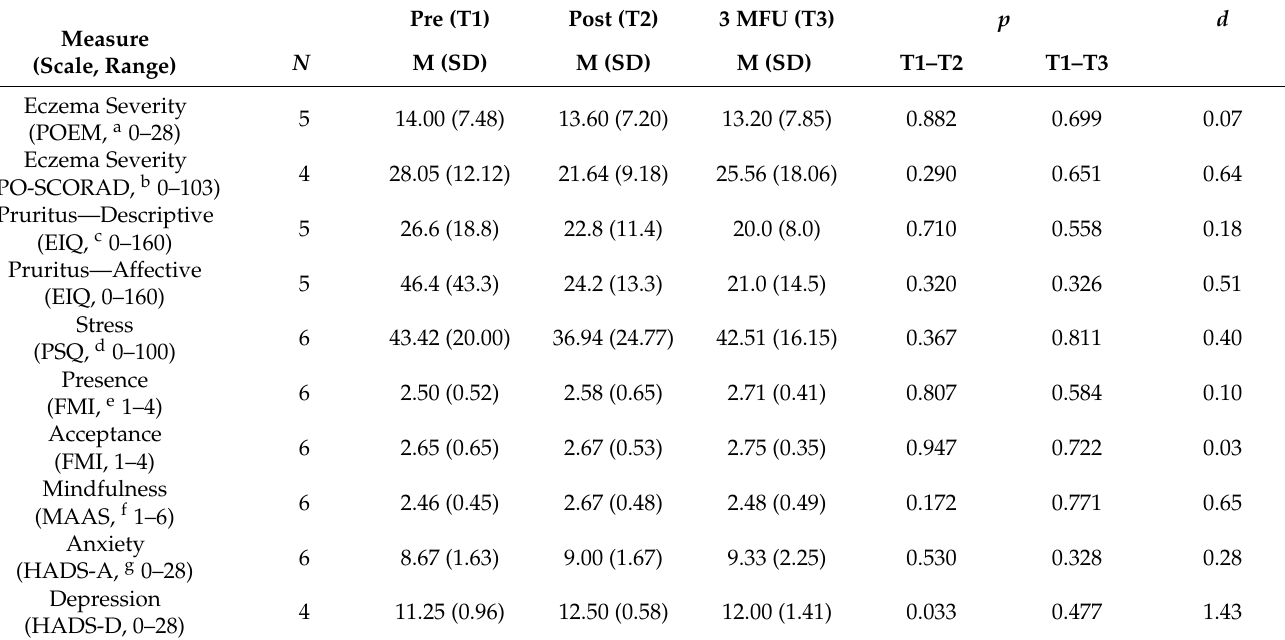
Table 2. Means, Standard Deviations and Effect Sizes (Cohen’s d).